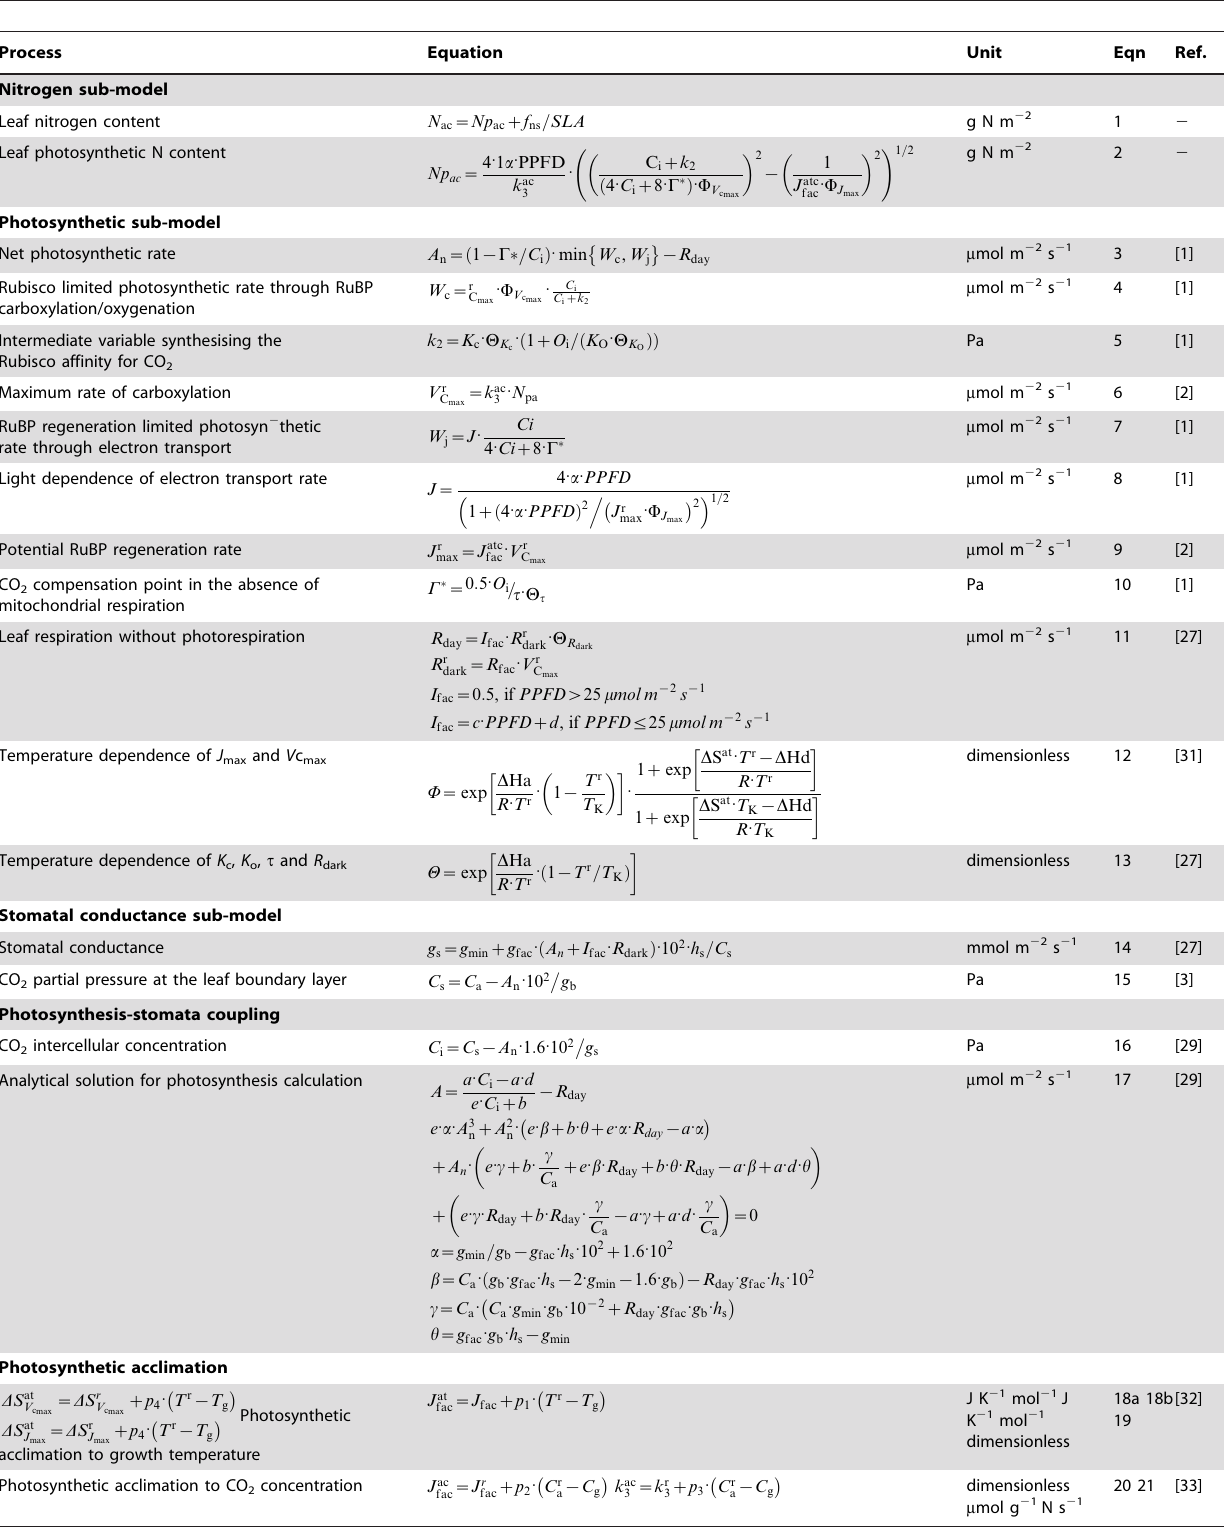
Table 1. Equations of the photosynthesis - stomatal conductance models.